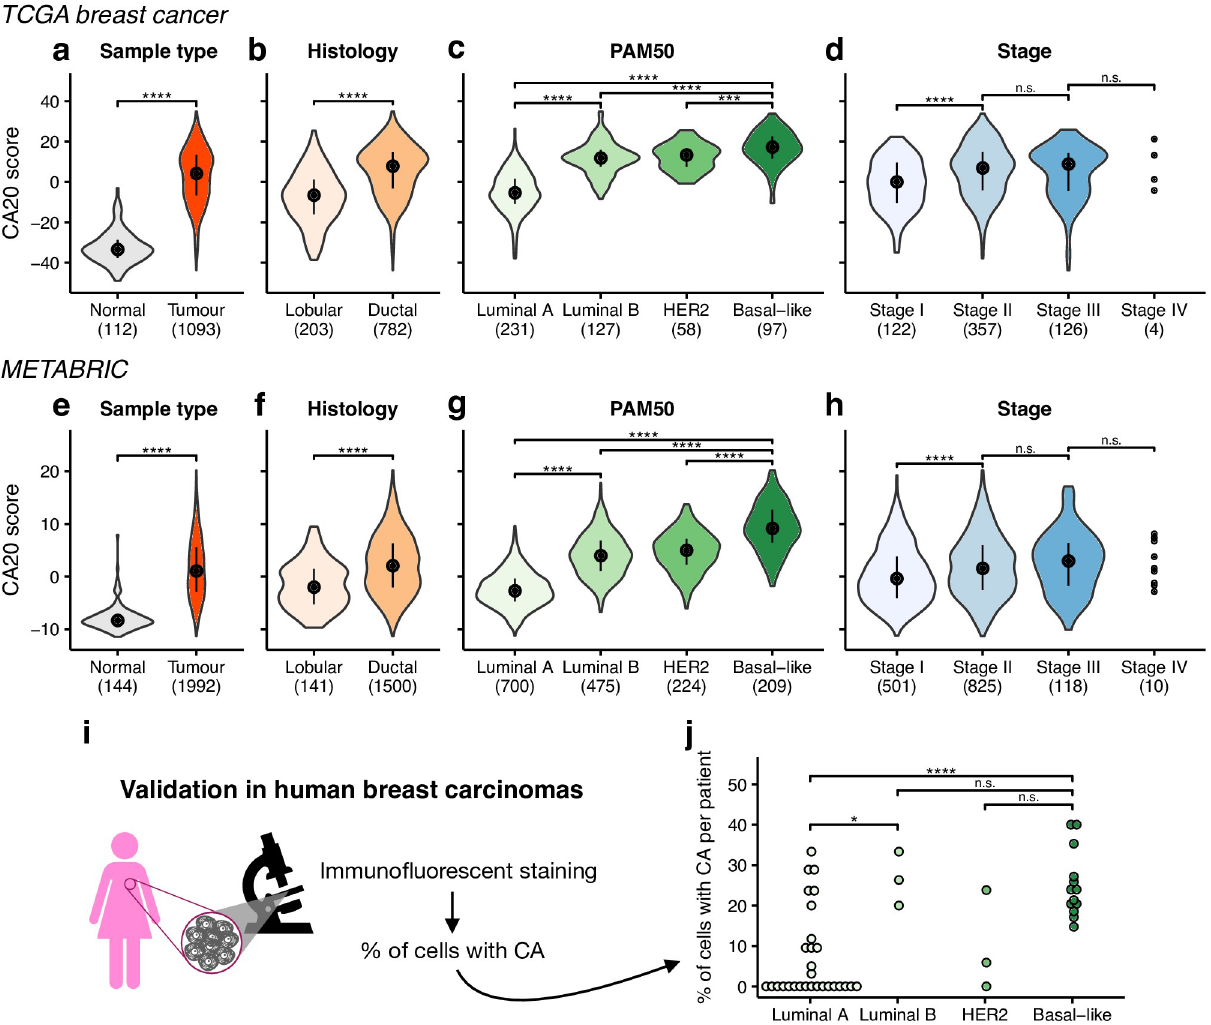
Fig 2. CA20 is associated with different breast cancer clinical and molecular features. (a-h) CA20 score distribution per ( a , e ) sample type, ( b , f ) histological and ( c , g ) PAM50 molecular subtype, and ( d , h )tumour stage for ( a - d ) TCGA breast cancer and ( e - h ) METABRIC samples. Black points and lines represent the median +/- upper/lower quartiles. Number of samples used in each violin is shown within brackets. ��� p-value < 0.001, ���� p- value < 0.0001 and n.s. non-significant (Wilcoxon rank-sum test). (i-j) Luminal B and basal-like human breast carcinomas display higher levels of centrosome amplification (CA). (i) Illustration of the procedure to quantify CA in patient samples. (j) Percentage of cells displaying CA in breast tumours from the different PAM50 molecular subtypes (29 luminal A, 3 luminal B, 3 HER2 and 13 basal-like). Between 5 and 107 cells were analysed for each patient. � p-value < 0.05, ��� p-value < 0.001 and n.s. non-significant (Wilcoxon rank-sum